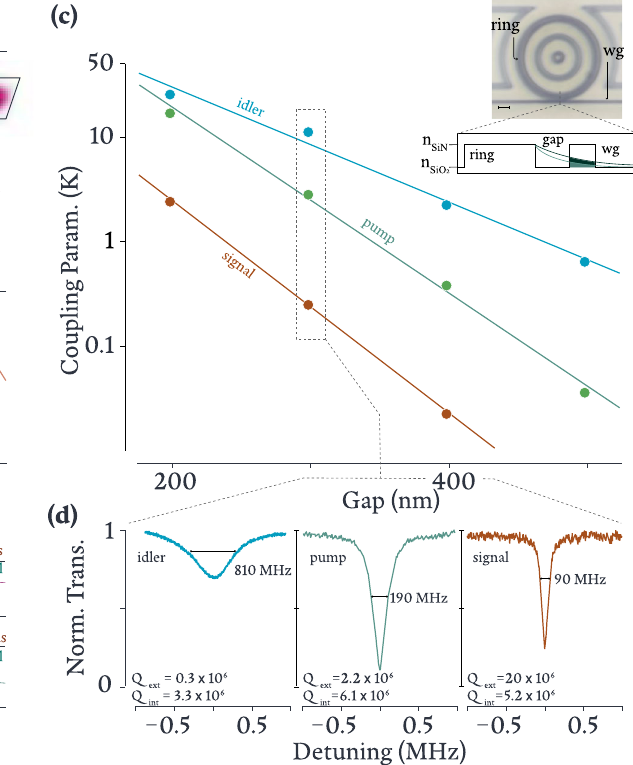
Fig. 2 | Frequency matching, dispersion, and coupling. a Frequency mismatch Δ ν = − 2 ν p + ν s + ν i for the hOPO in orange. The solid circles are experimental mea- surements using a wavemeter (see Methods) to determine the cold-cavity reso- nance frequencies (uncertainties are within the size of the data points), while the solidcurveisfrom fi nite-elementmethod(FEM)simulationswheretheidler,pump, and signal modes are from the TE 0 , TE 0 , and TM 0 mode families, respectively. The frequencymismatchwhenallmodesarechosenfromtheTE 0 familyisshowninthe green solid circles and green solid curve for experiment and simulations, respec- tively. The top images are the simulated transverse electric fi eld pro fi les for the hOPO modes, where the cross-sectional parameters of ring width (RW), thickness ( H ), and sidewall angle ( θ ) are indicated. The lower inset magni fi es the right zero crossingofthehOPO Δ ν curve,showingan ≈ 9GHzoffsetwhen μ =76. b Dispersion parameter( D )fortheTM 0 andTE 0 modefamilies,withexperimentaldatashownas